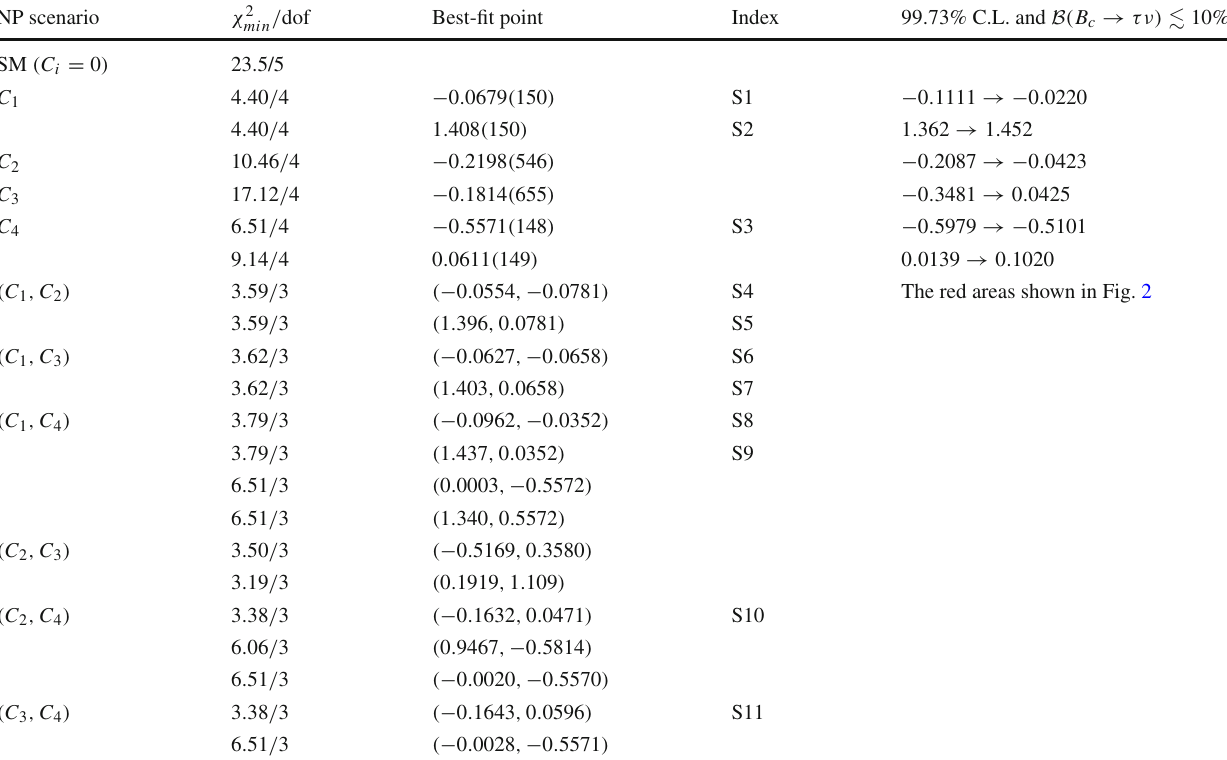
Table 3 Best-fit solutions of the NP Wilson coefficients C i at the scale (cid:4) = 1 TeV, under the combined constraints from the measured R ( D ) , R ( D ∗ ) , P τ ( D ∗ ) , R ( J /ψ) , and R ( X c ) . See text for